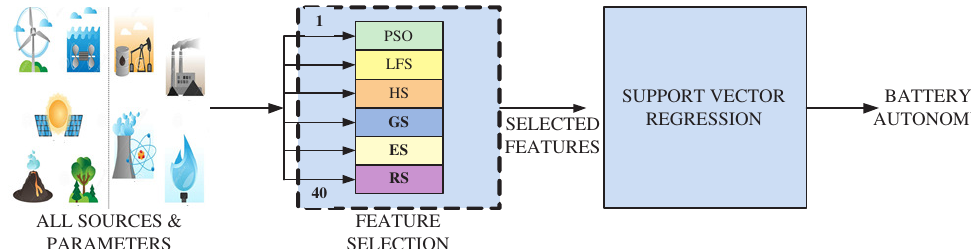
Figure 2. Proposed methodology for optimum